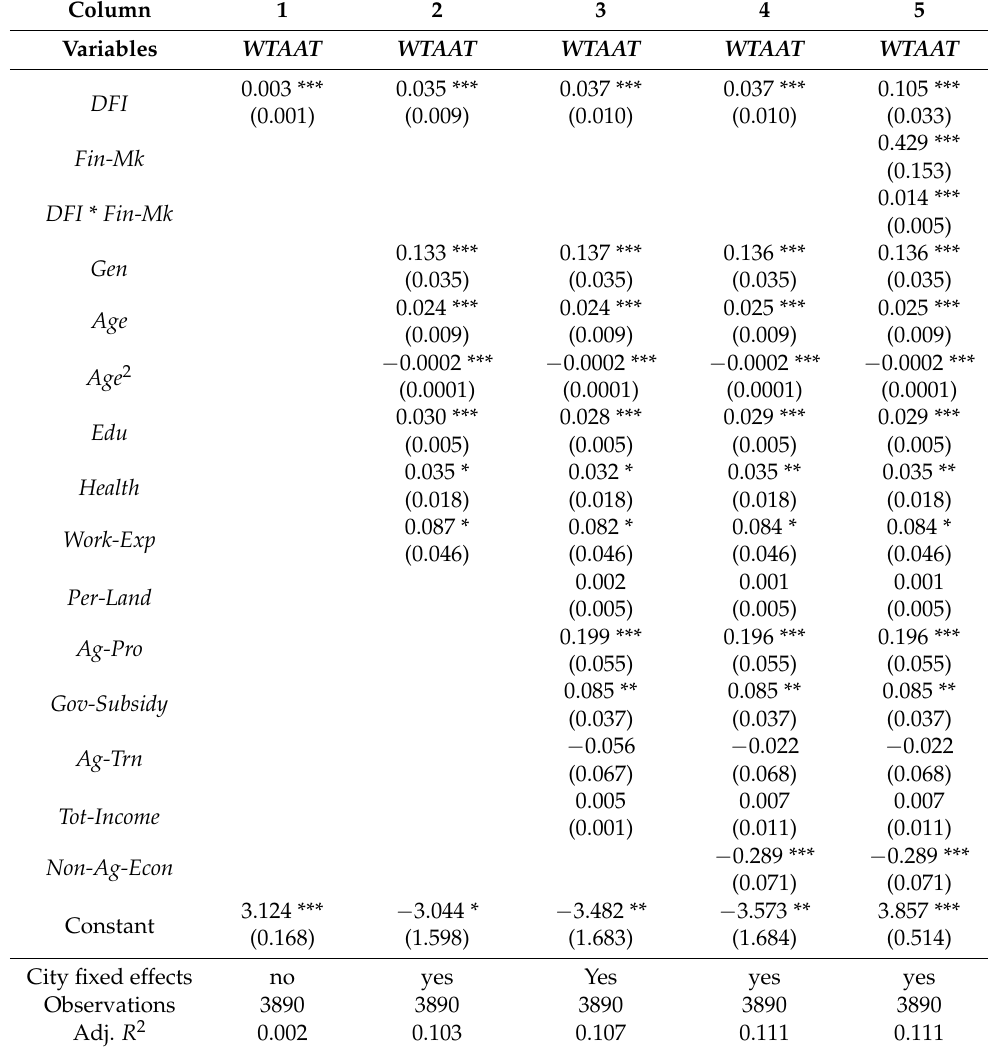
Table 2. Baseline model and moderating effect estimation